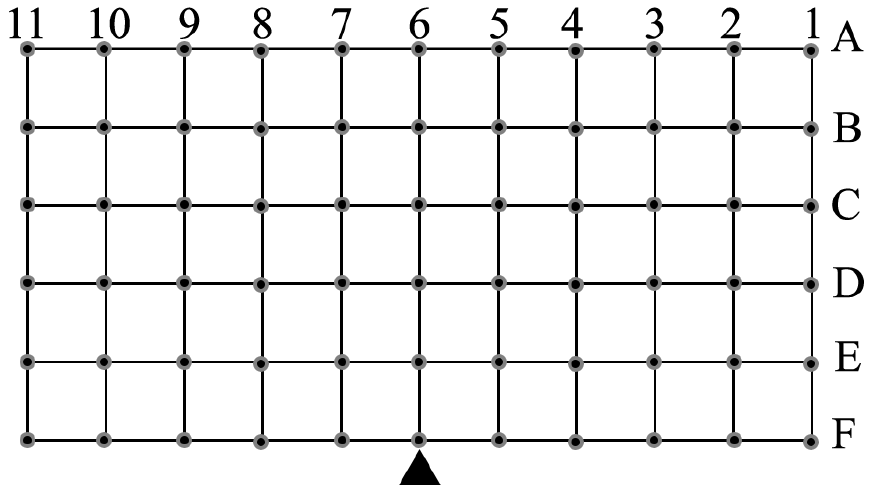
Figure 6. Working area adopted to assess the system behavior in terms of multiple object identification (MOI). Dimensions are 100 by 50 cm with each step measuring 10 cm.